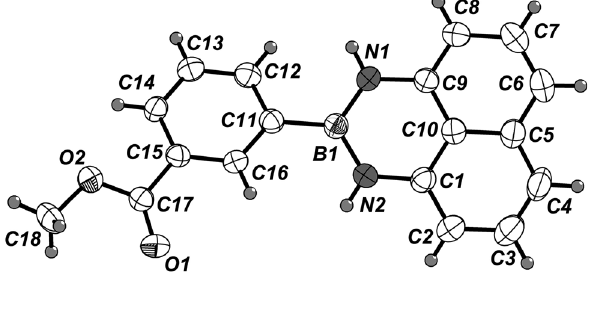
Table  : Data collection and